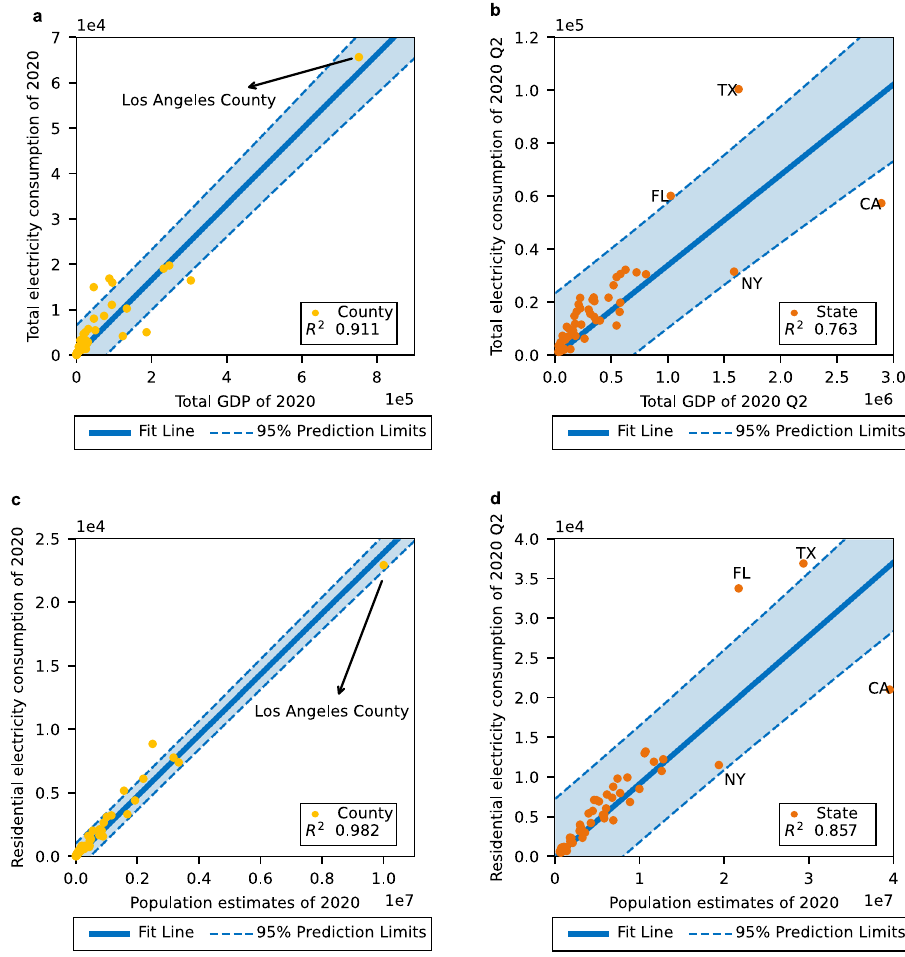
Fig. 6 | EC relationship with GDP and population. a Total EC and total GDP of eachcountyinCaliforniain2020. b TotalECandtotalGDPofeachstateintheU.S. in 2020 Q2. c ResidentialECand populationestimates of each county in California in 2020. d Residential EC in 2020 Q2 and population estimates for 2020 for each